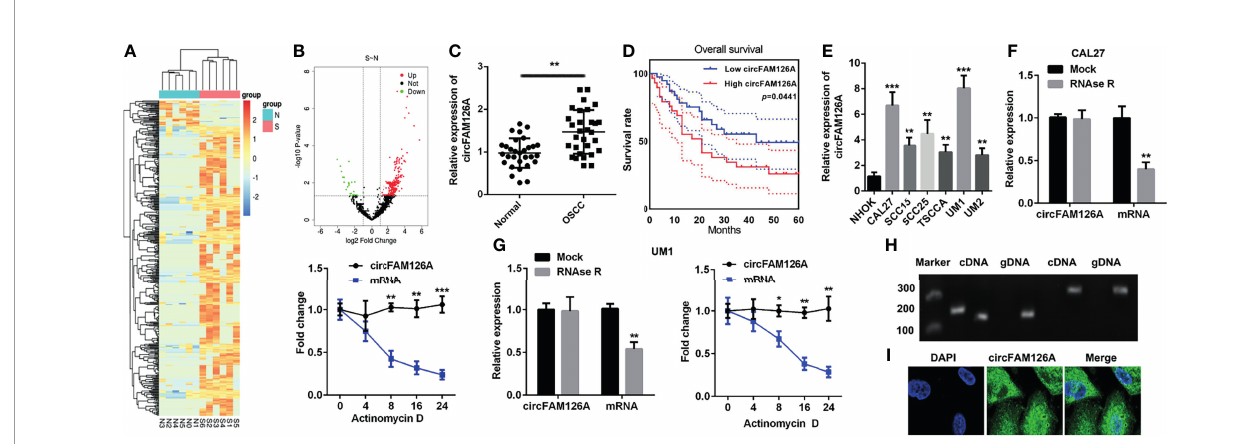
FIGURE 1 | circFAM126A is upregulated in OSCC. (A, B) Microarray analysis the differentially expressed circRNAs in OSCC. (C) Expression of circFAM126A in clinical samples. (D) The overall survival of OSCC patients. (E) Expression of circFAM126A in OSCC cells. (F) Relative RNA levels and RNA stability in CAL27 detected by qRT-PCR. (G) Relative RNA levels and RNA stability in UM1 detected by qRT-PCR. (H) Primers ampli fi ed in cDNA or gDNA determined by qRT-PCR. (I) Locations of circFAM126A detected by fl uorescence assay. S: OSCC patients; N: normal group. * P <0.05, ** P <0.01, *** P